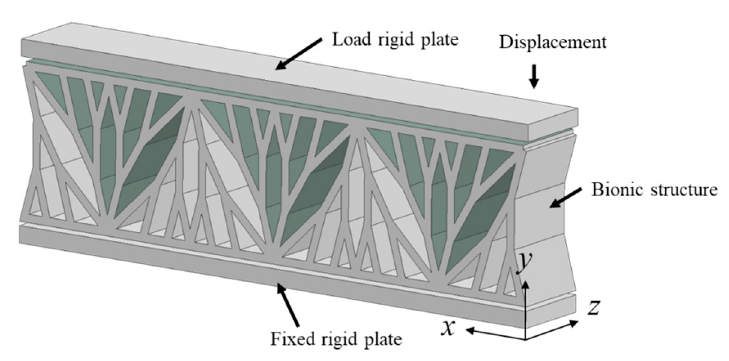
Figure 6. Finite element (FE) model of 15 degrees bionic structure.